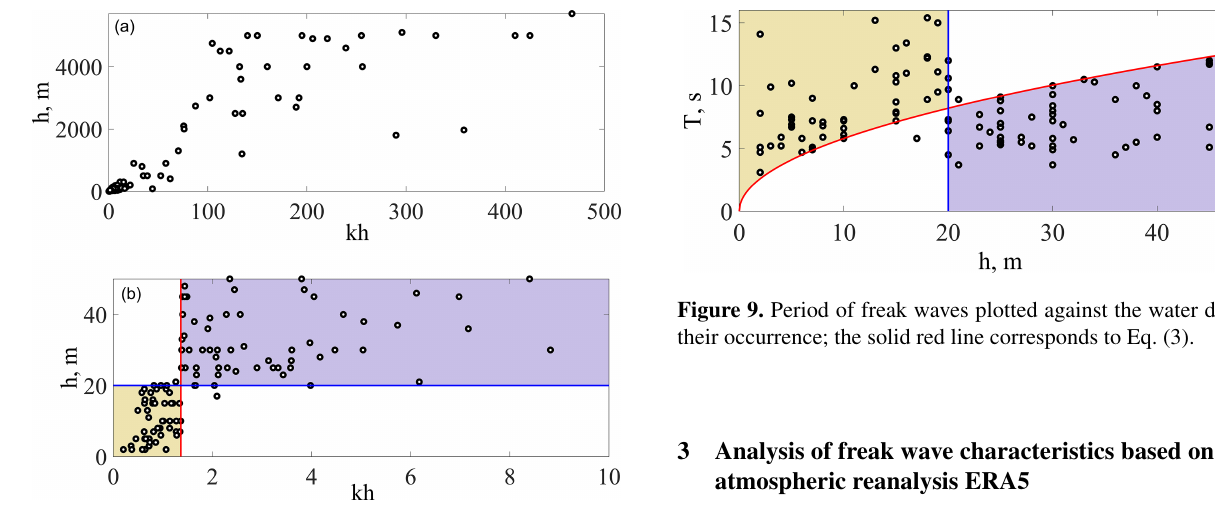
Figure 8. The parameter kh versus the water depth (red line cor- responds to the threshold of the criterion of modulational instabil- ity): (b) is a zoomed-in image of (a) .